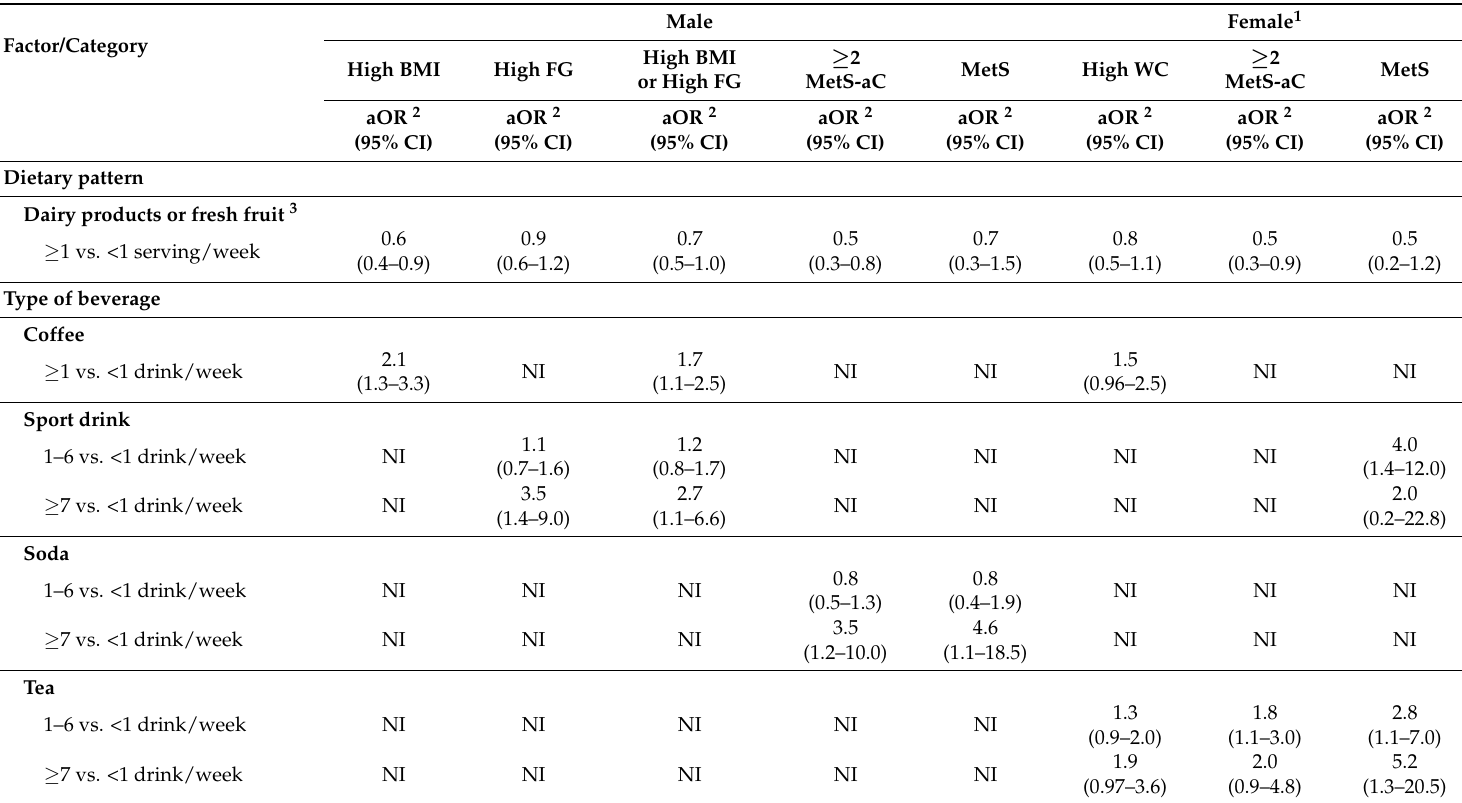
Table 6. Multivariable-adjusted odds ratio (aOR) of the clustering of MetS risk components associated with significant dietary habits in adolescents, Taiwan. Male Female 1 Factor/Category ≥ High BMI High BMI High FG or High FG